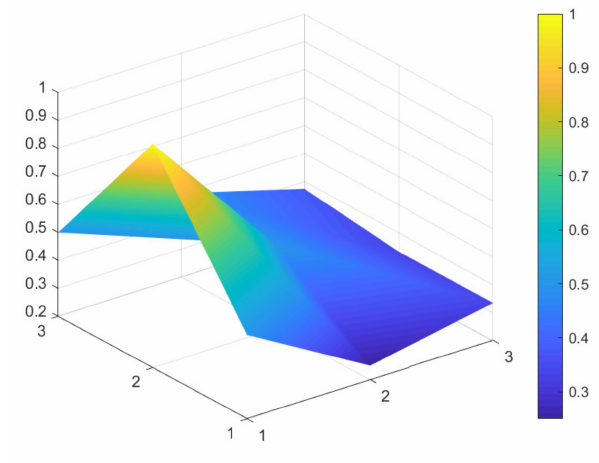
Figure 7. PMC-Surface chart of P13